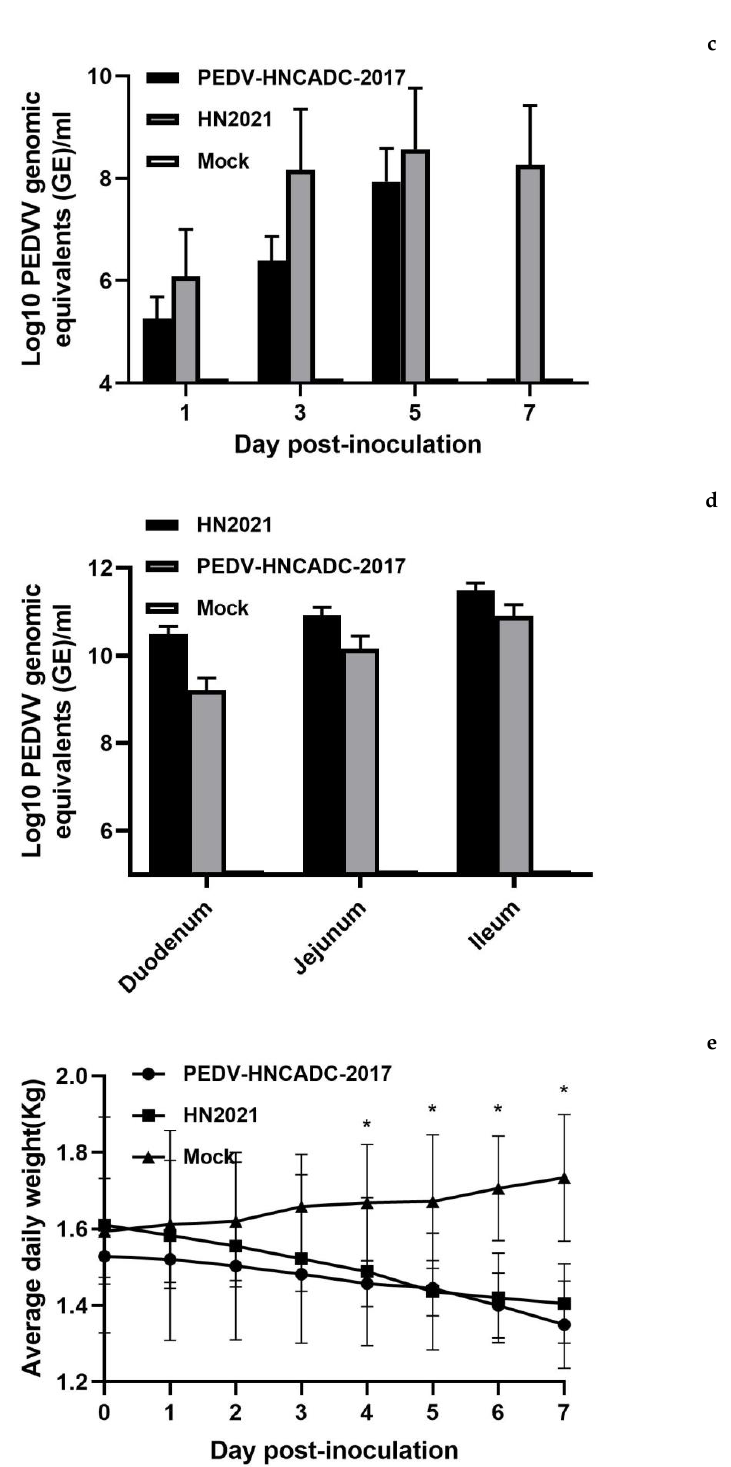
Figure 5. Pathogenicity analysis of PEDV isolates in new-born piglets. ( a ) The severity of diarrhea was scored based on clinical examination; 0, normal and no diarrhea; 1, mild and fluidic feces; 2, moderate watery diarrhea; 3, severe watery and projectile diarrhea; 4, death. ( b ) Survival rate of piglets in each group. ( c ) Fecal virus shedding in PEDV-challenged and control groups by RT-qPCR. ( d ) Viral RNA shedding titers of each group were determined by RT-qPCR in the duodenum, jejunum and ileum of piglets. ( e ) The piglet body weights between the two PEDV-challenged groups and control groups were compared. Error bars indicate the standard deviations from each group ( n = 3). * p <